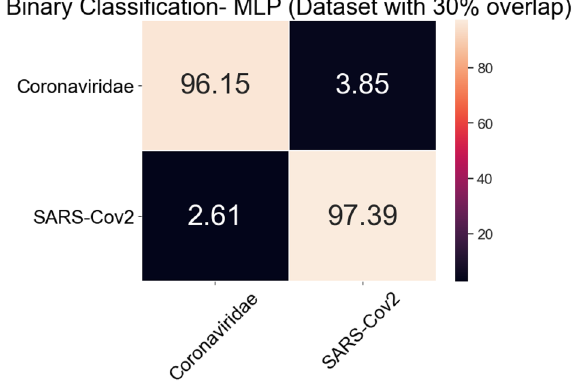
Figure 11. MLP average Confusion Matrix for binary classification task (Coronaviridae vs. SARS-CoV-2 using the 30% overlap dataset).